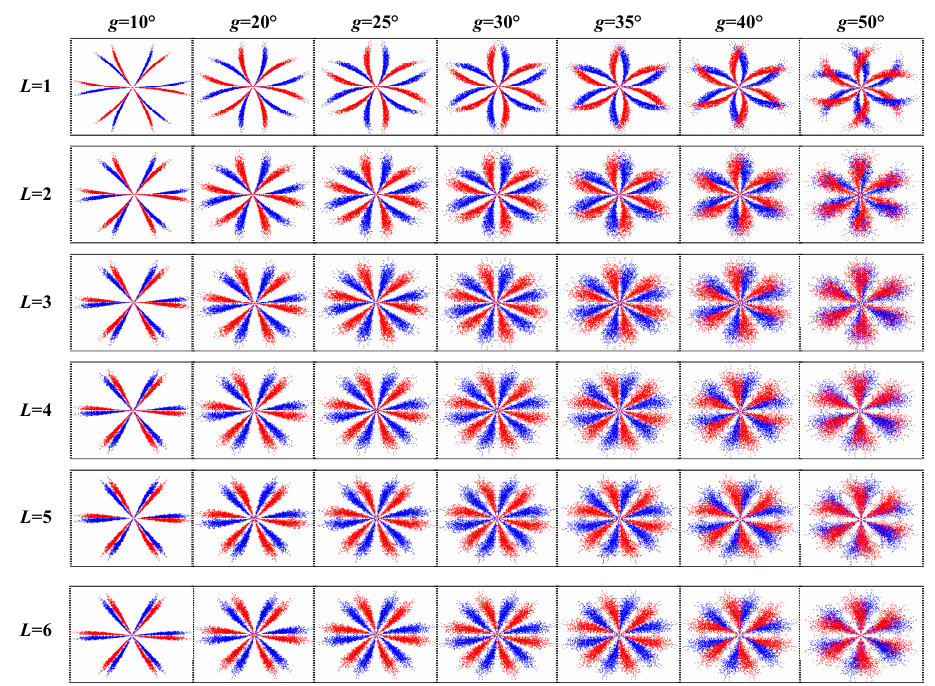
Figure 8. SDP images for various values of 𝑔 and 𝐿 .